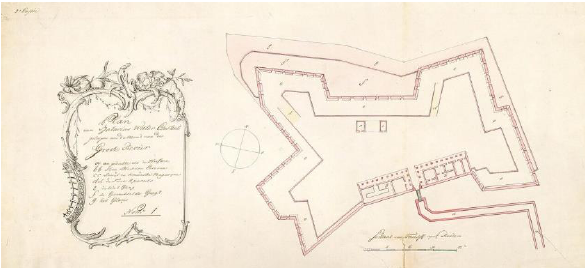
Figure 17. The design for the Waterkasteel, displaying the plan, circa